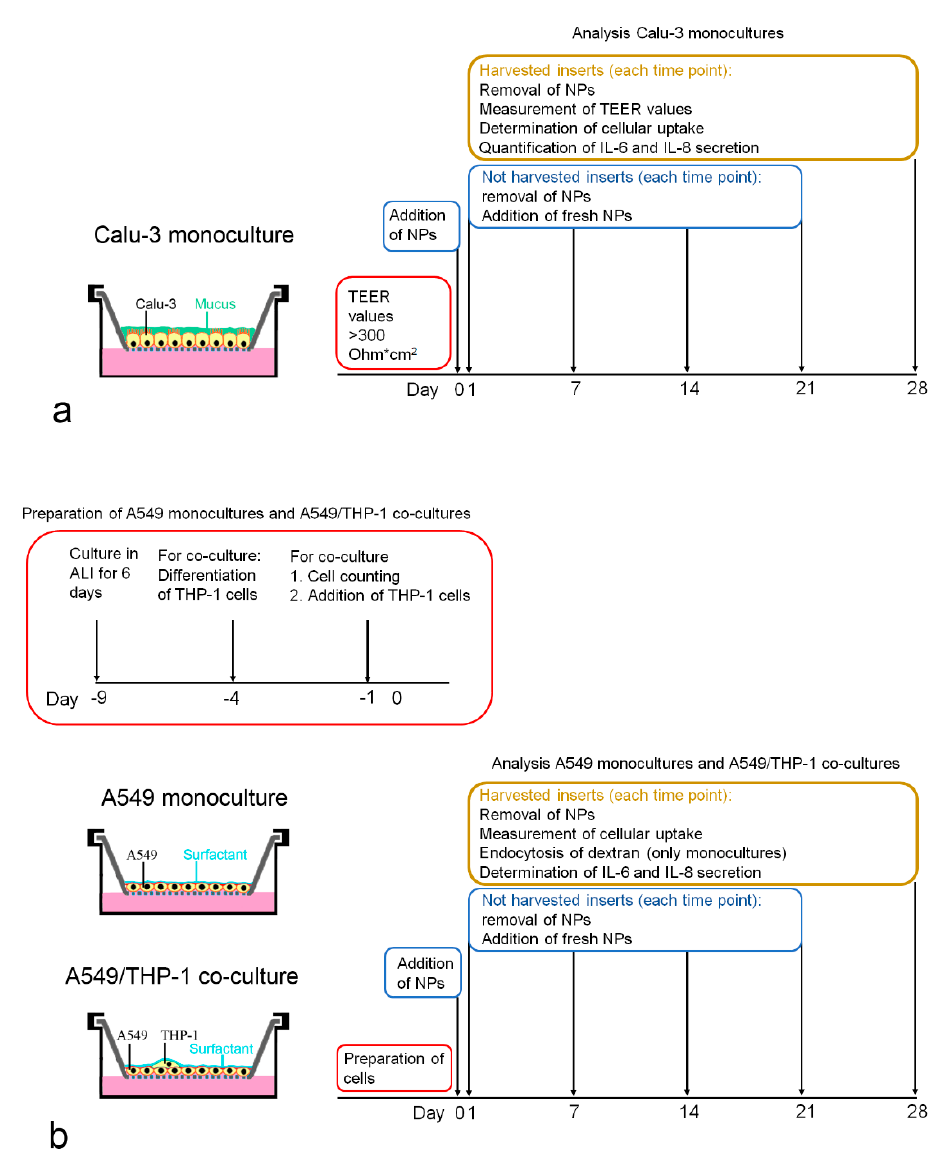
Figure 1. Schematic representation of Calu-3 monoculture ( a ), A549 monoculture and A549/THP-1 co-culture ( b ), preparation of the cells, particle exposures and analyses at each time point.